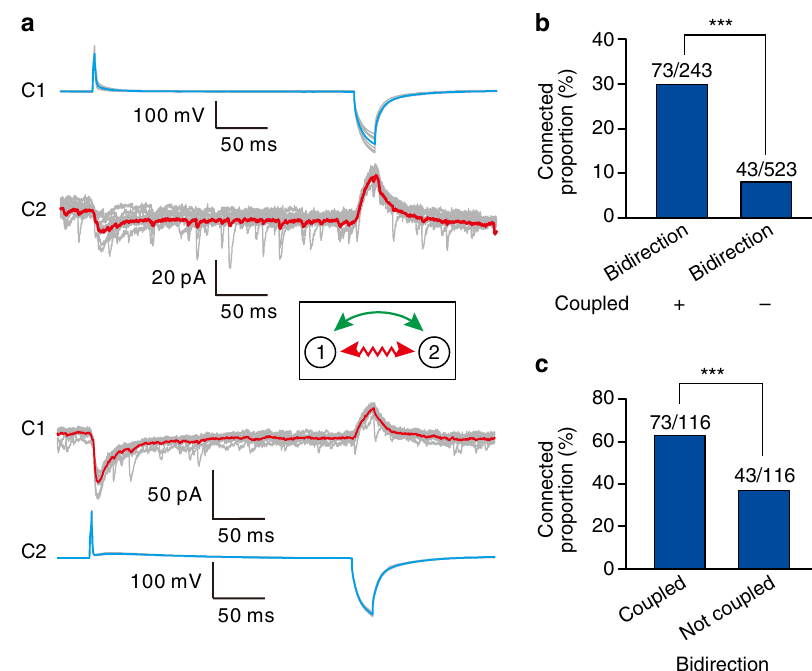
Figure 3 | Preferential existence of bidirectional chemical connections in electrically coupled pairs. ( a ) A representative sample pair with bidirectional chemical connection and reciprocal electrical connection between two layer 1 interneurons. APs and hyperpolarization sequentially triggered in the presynaptic neurons (blue traces) and responses (red traces) of GABAergic connections (inward currents) and electrical connections (outward currents) recorded in the postsynaptic neurons. The bold traces represent the average and the grey traces represent the individual traces. A schematic diagram showing electrical and GABAergic connections between the two neurons (inset). Wavy red arrowheads indicate electrical connections, and green arrowheads indicate GABAergic connections. ( b ) Bidirectional chemical connections between layer 1 interneurons preferentially existed in electrically coupled pairs. ( c ) Layer 1 interneuron pairs connected by bidirectional chemical synapses preferentially formed electrical synapses. *** P o 0.001, w 2